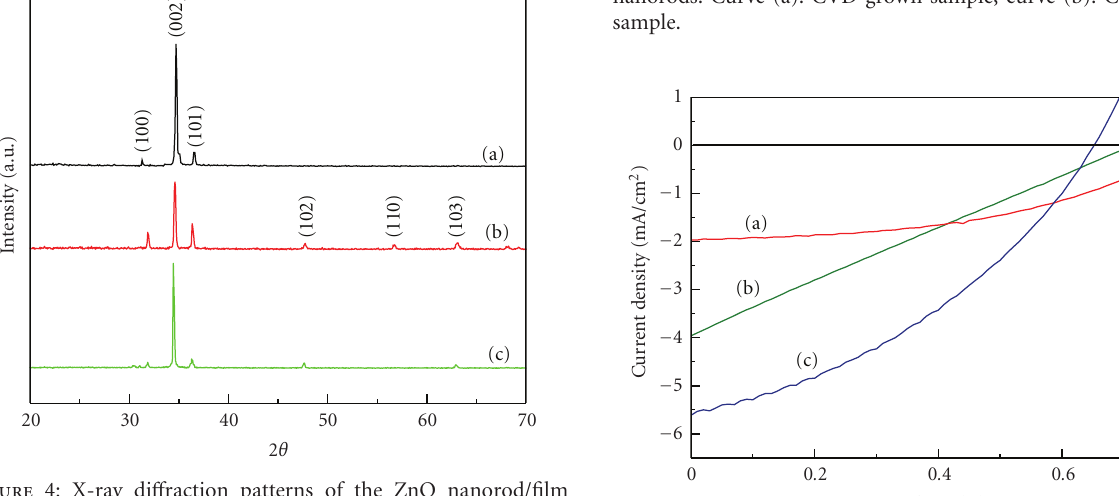
Figure 4: X-ray di ff raction patterns of the ZnO nanorod/film samples. curve (a): CVD grown, curve (b): CBD grown, and curve (c): conventional.